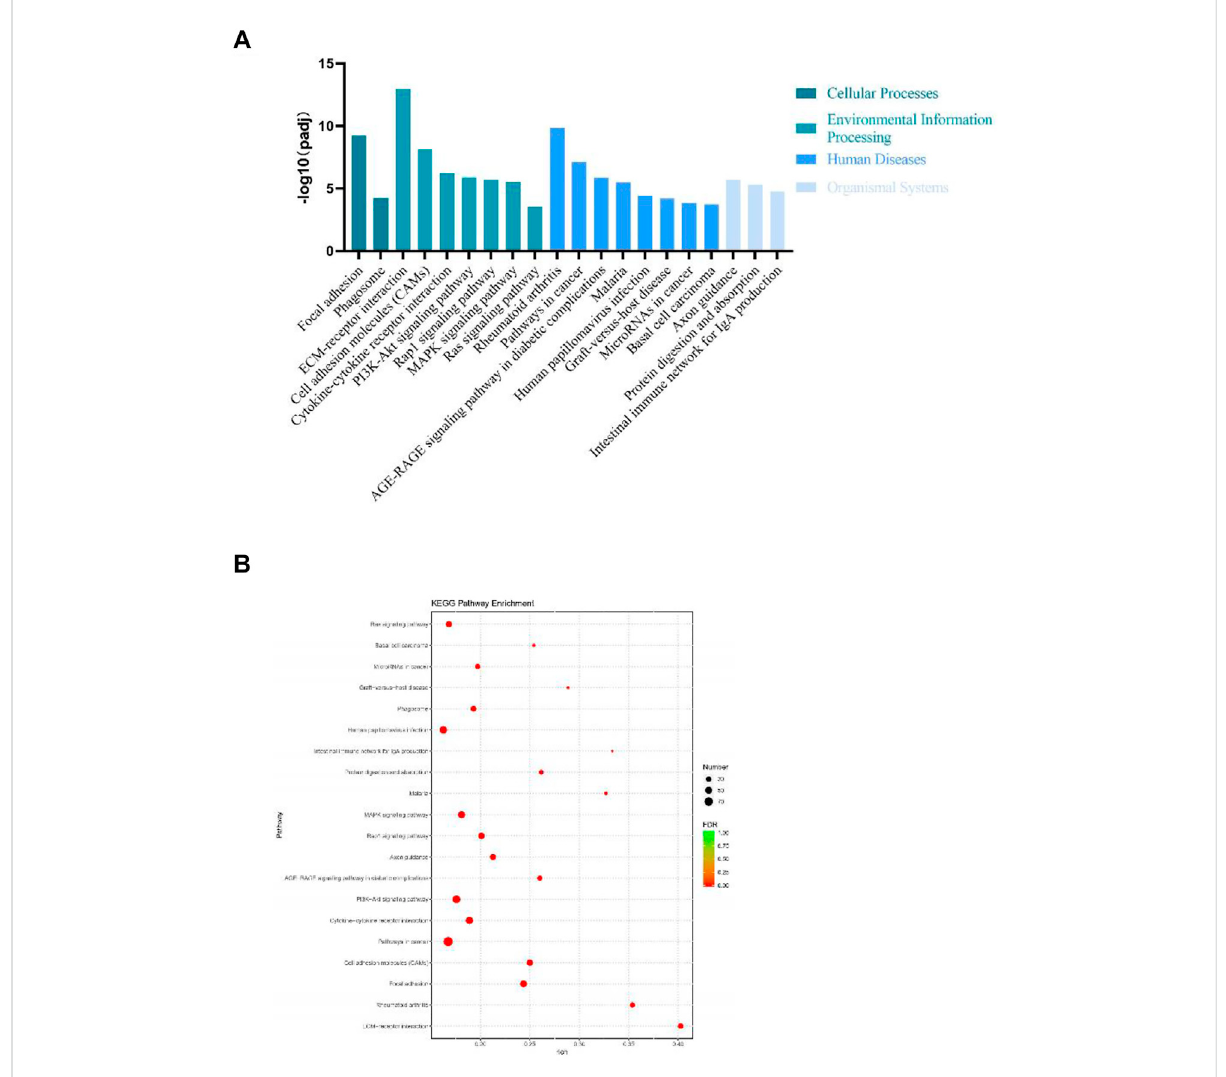
FIGURE 5 KEGG enrichment analysis of DEGs from BMSCs in high glucose microenvironment at 35 mM concentration for 30 days. (A) KEGG pathway enrichment analysis histogram. (B) KEGG enrichment analysis bubble map.